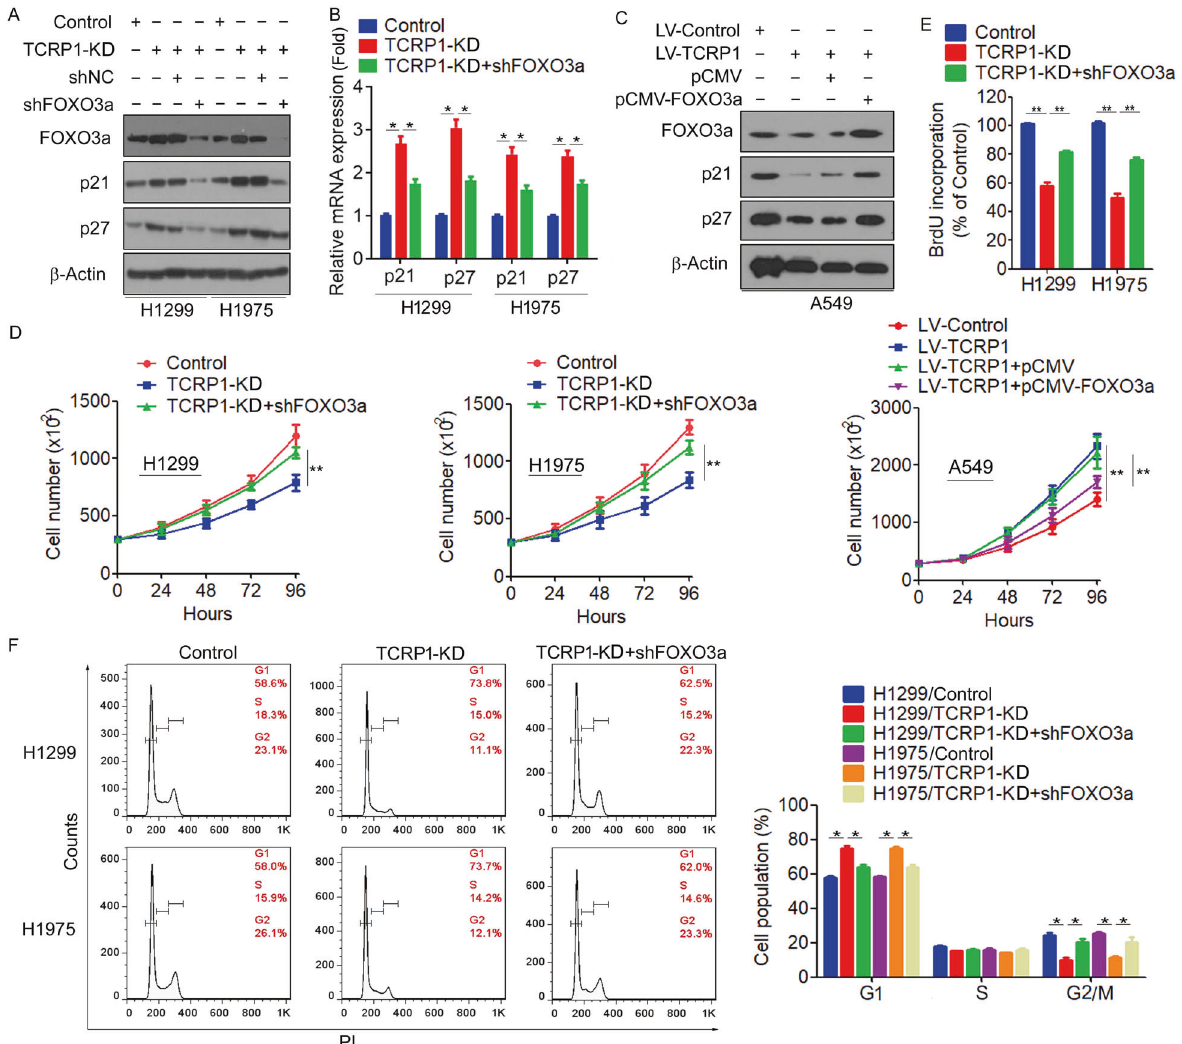
Fig. 7 FOXO3a reversed the effect of TCRP1 on NSCLC cell proliferation. shRNA targeting FOXO3a was transfected into H1299 cells and H1975 cells with decreasing TCRP1, western blot ( A ) and qRT-PCR assays ( B ) were performed to assess the expression level of FOXO3a, p21 and p27. vs TCRP1-KD, vs Control, * P < 0.01. ( C ) Restored overexpression of FOXO3a in A549 cells with increasing TCRP1, the protein levels of FOXO3a, p21 and p27 were determined by western blot assays. Cell viability assays ( D ) and BrdU assays ( E ) were performed to verify